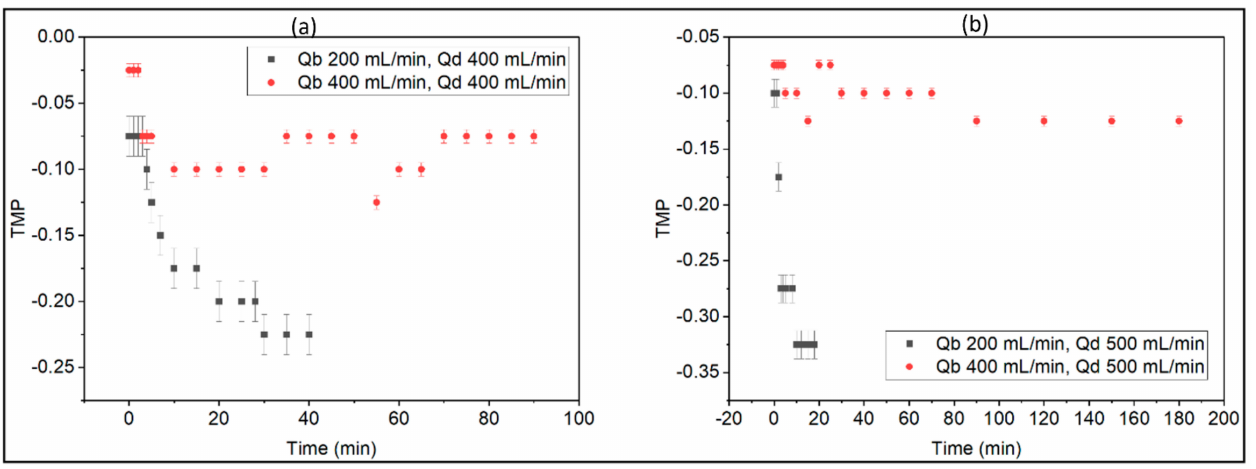
Figure 4. SEM images of the PAES membrane surface ( a ) before and ( b ) after contact with FB solution.